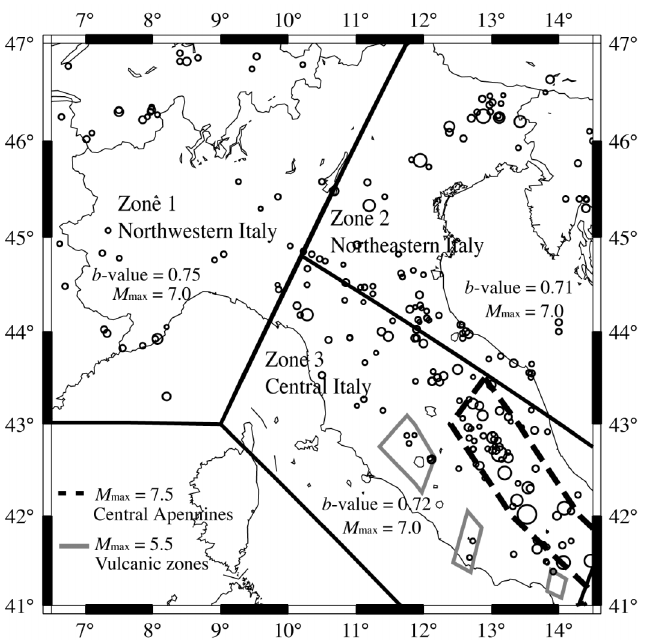
Fig. 1. Regionalization of the study area. The maximum magnitude, M max is assumed 7.5 for the Central Apen- nines, 5.5 for volcanic regions and 7.0 elsewhere. The b -value is assumed constant and is estimated separately in each macro zone: values obtained using a Maximum Likelihood Method are 0.75 (Northwestern Italy), 0.71 (Northeastern Italy) and 0.72 (Central Italy). Circles show locations of historical events of CPTI catalogue (Gruppo di Lavoro CPTI, 1999) with magnitude larger than or equal to